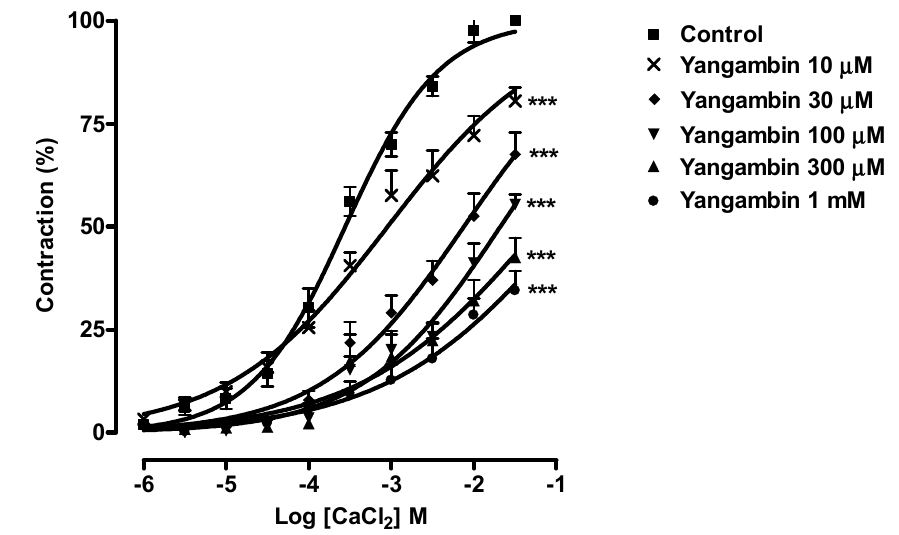
Figure 5. Inhibitory effect of yangambin on CaCl endothelium-denuded mesenteric rings. Concentration–response curves for CaCl determined in the absence (control) and after the incubation with yangambin at 10, 30, 100, 300 μ M or 1 mM (n = 5). Results are expressed as mean ± S.E.M. *** p < 0.001 vs.